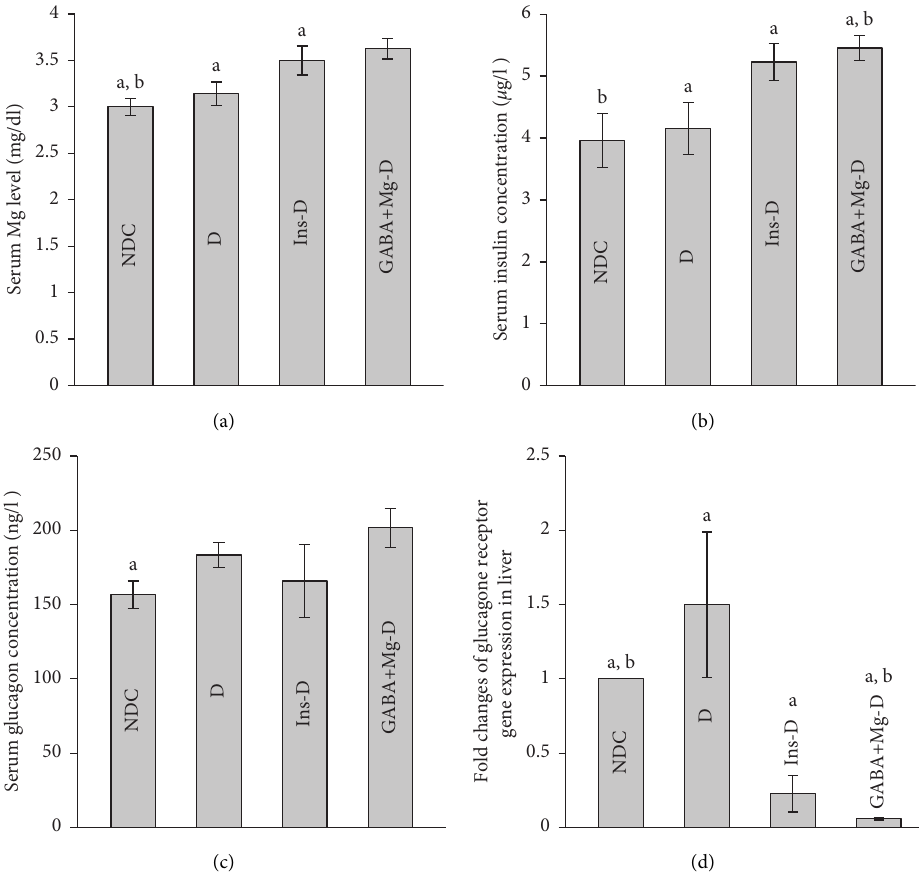
Figure 3: Comparison of serum magnesium level. (a) Glucagon, (b) insulin concentrations, (c) and gene expression of glucagon receptor in liver. (d) Control group without diabetes was fed with a normal diet, the chronic diabetic group received high-fat diet and 35 mg/Kg STZ (D), diabetic animals were treated with insulin (2.5 U/Kg two times per day) (Ins-D), and diabetic animals treated with GABA (1.5gr/kg) +MgSO 4 (10 g/l add in drinking water) (GABA +Mg-D) (10 rats in each group. data are expressed as mean ± SEM). (a) Significant difference between D and other groups ( P < 0.001). (b) Significant difference between NDC group and GABA+Mg-D ( P <